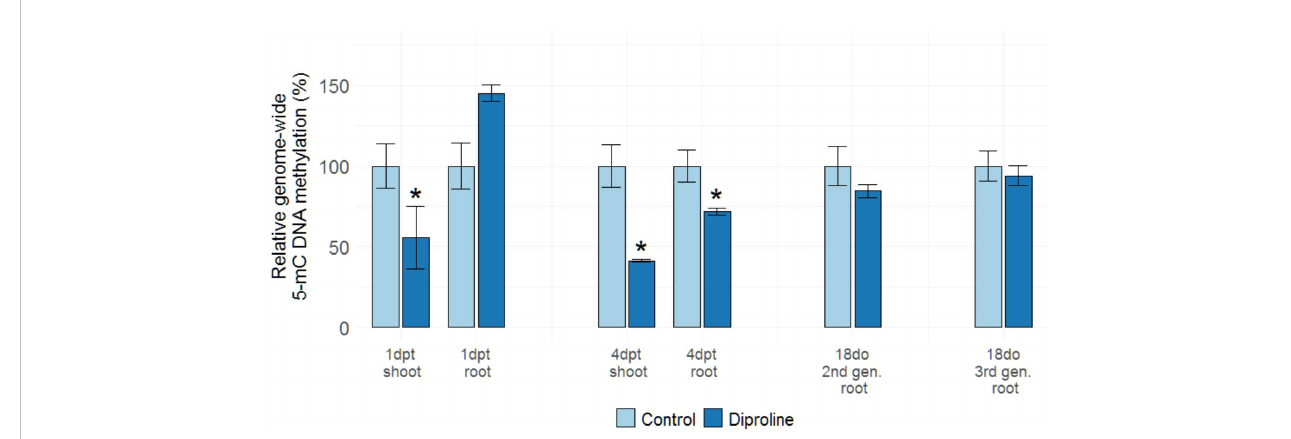
FIGURE 5 DNA methylation levels in rice roots and shoots upon diproline treatment and in TIR plants. Genome-wide 5-mC DNA methylation levels as assessed by ELISA assays are shown and expressed relative to methylation levels of uninoculated, same-aged and mock-treated or untreated control plants. For the analysis on ancestor plants one and four days post treatment (1 dpt and 4 dpt, respectively), fourteen-days-old rice plants were foliarly treated with 500 µM diproline, while mock-treated plants were used as controls. All second and third generation progeny plants remained untreated and were studied when being eighteen days old (18do). Error bars represent the standard error of the mean. Asterisks indicate signi fi cant differences determined via a two- sided heteroscedastic t-test (p <